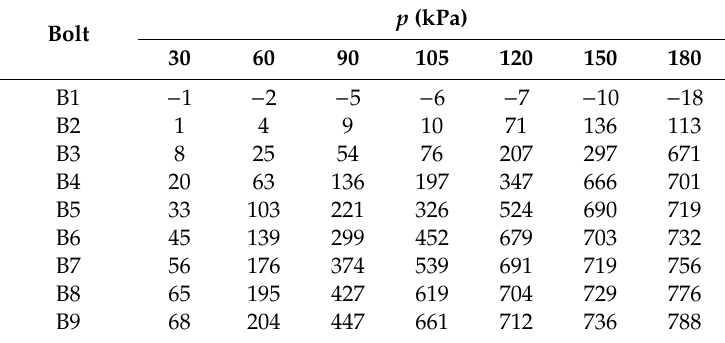
Table 4. The stress of bolts at each loading step in E9 (unit: MPa).